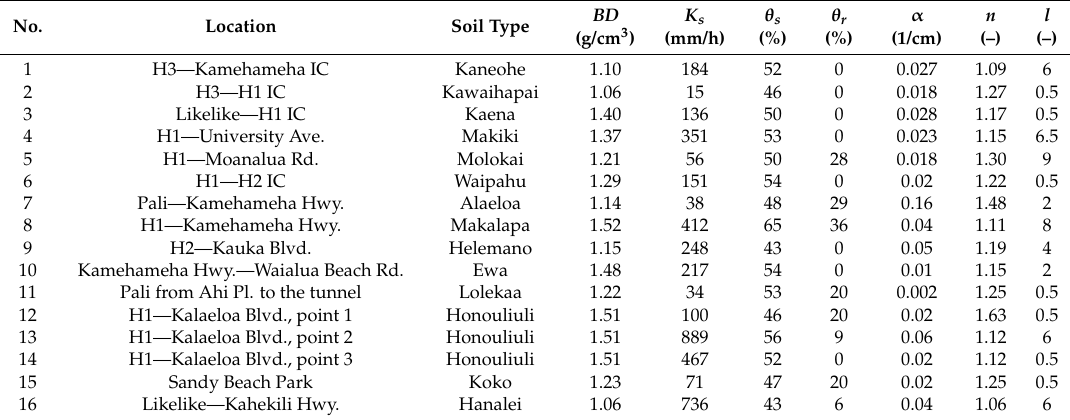
Table 1. Measured bulk density ( BD ), saturated water content ( θ s ), estimated saturated hydraulic conductivity ( K s ), residual water content ( θ r ) and Van Genuchten parameters ( α , n , l ) for soils along Oahu highways. K s , θ r , α , n , and l were estimated using the RETC program of Van Genuchten et al. [37] using Van Genuchten/Mualem model with ( m = 1 − 1/ n ) [39]. Depth of soil samples was 30–50 cm.